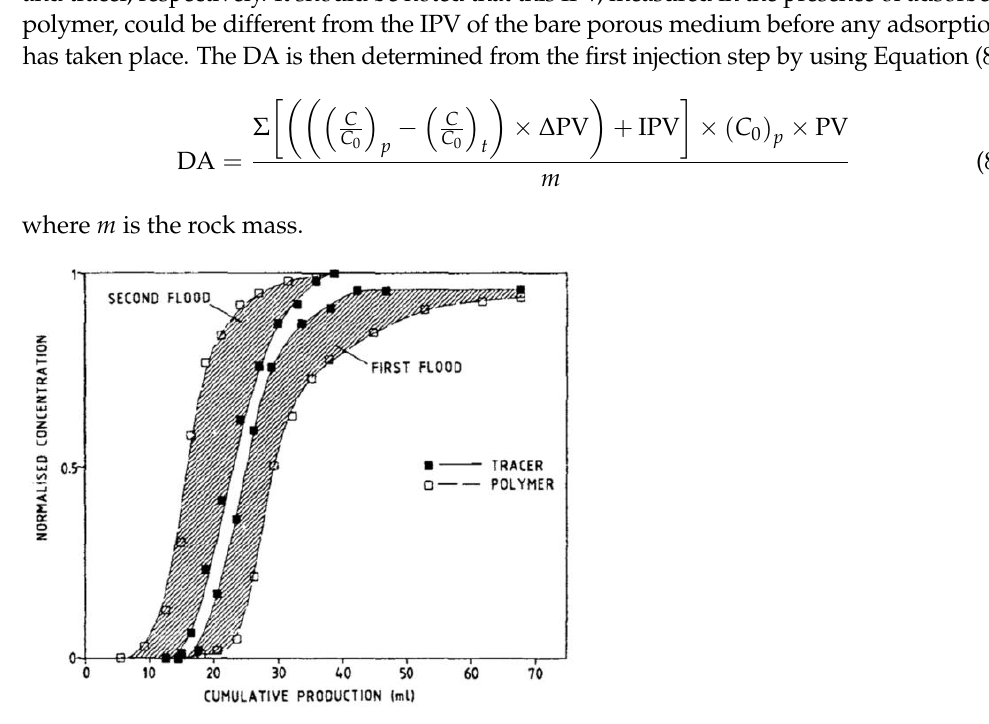
Figure 3. The tracer and polymer normalized concentration profiles in the effluent in the double-injection method for polymer retention measurement in porous media. Adapted with permission from